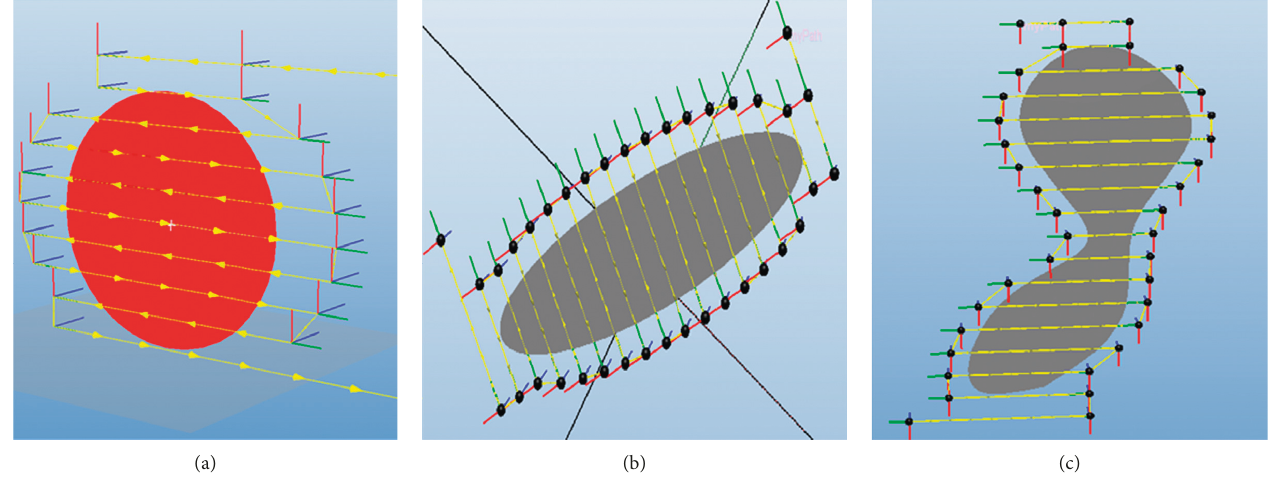
Figure 13: Autogenerated trajectory on a type of curved-edge